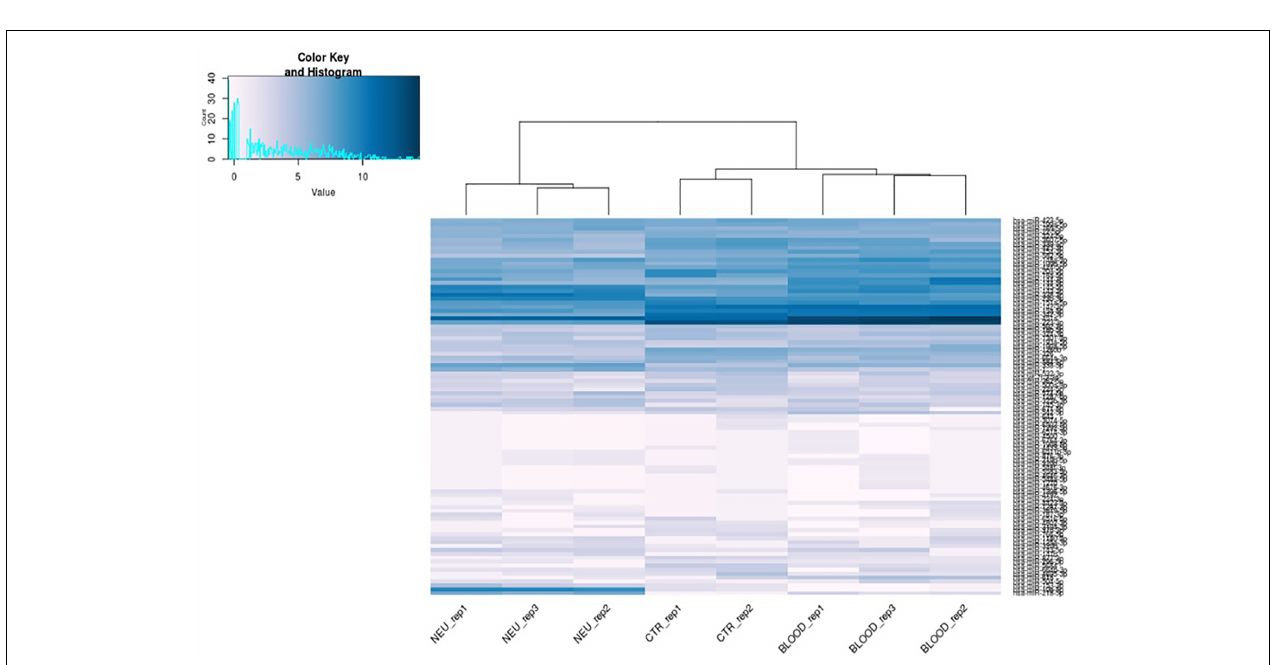
FIGURE 2 | Panel (A) shows the amount of dysregulated miRNAs in the comparison between the neuromuscular junctions and the control blood samples. Panel (B) shows the amount of dysregulated miRNAs in the comparison between the blood samples from ALS affected patients and the neuromuscular junctions. Panel (C) shows the amount of dysregulated miRNAs in the comparison between the blood samples from ALS affected patients and the control. Panel (D) shows the Venn diagram of dysregulated miRNAs in all the three comparisons.